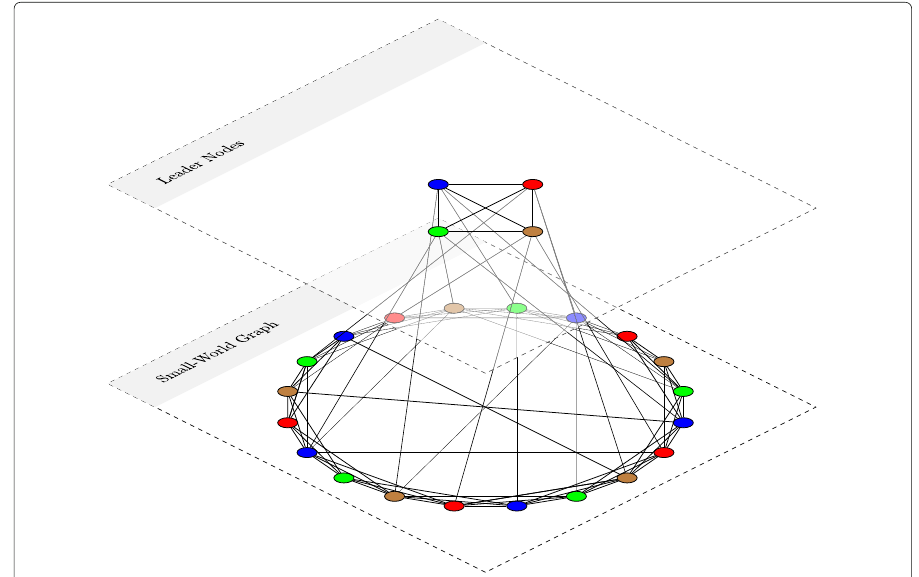
Fig. 1 Fully solved GCD network with χ = 4, based on a small-world graph with N = 20 nodes and 12 randomly added shortcuts (lower level), enriched by four leader nodes that form a complete subgraph (upper level). Between both levels, a total of 12 links connect the leader nodes with the ring. This figure illustrates the general principle of the graph coloring problem – finding a distribution of colors such that no same colors are linked (conflict-free coloring) and finding the minimal number of colors (the graph’s chromatic number)